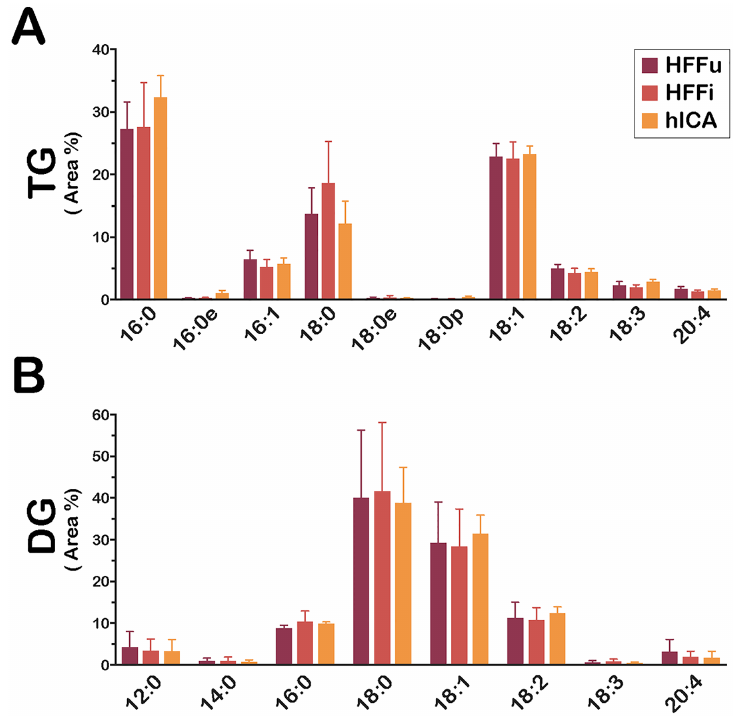
Fig 5. FA composition in TG and DG of T . cruzi intracellular amastigotes mirrors host cells. FA area % is plotted for (A) TG and (B) DG classes for HFF-derived samples, (C2C12 plotted in S5 Fig): uninfected HFF ( HFFu ), T . cruzi - infected HFF (HFFi ) and T . cruzi amastigotes purified from HFF ( hICA ).Data are represented as mean ± standard